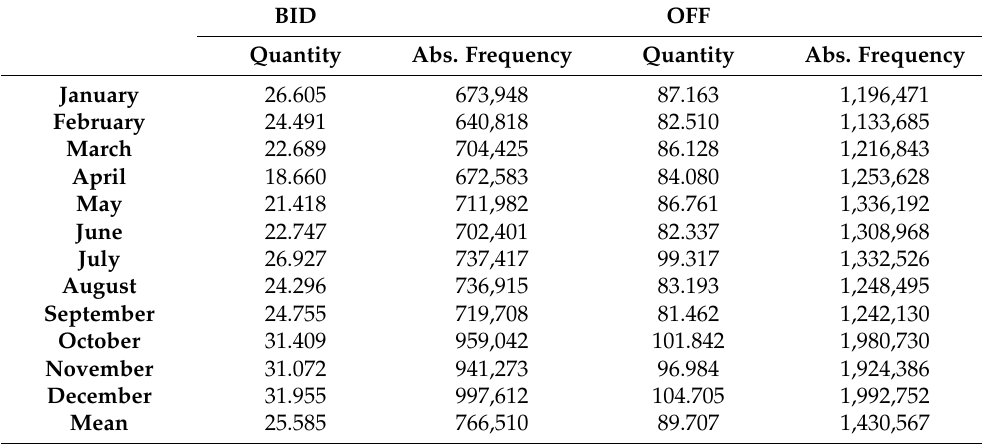
Table 1. Offer to Purchase (BID) and Sales (OFF): Monthly Total Quantity and Frequency.